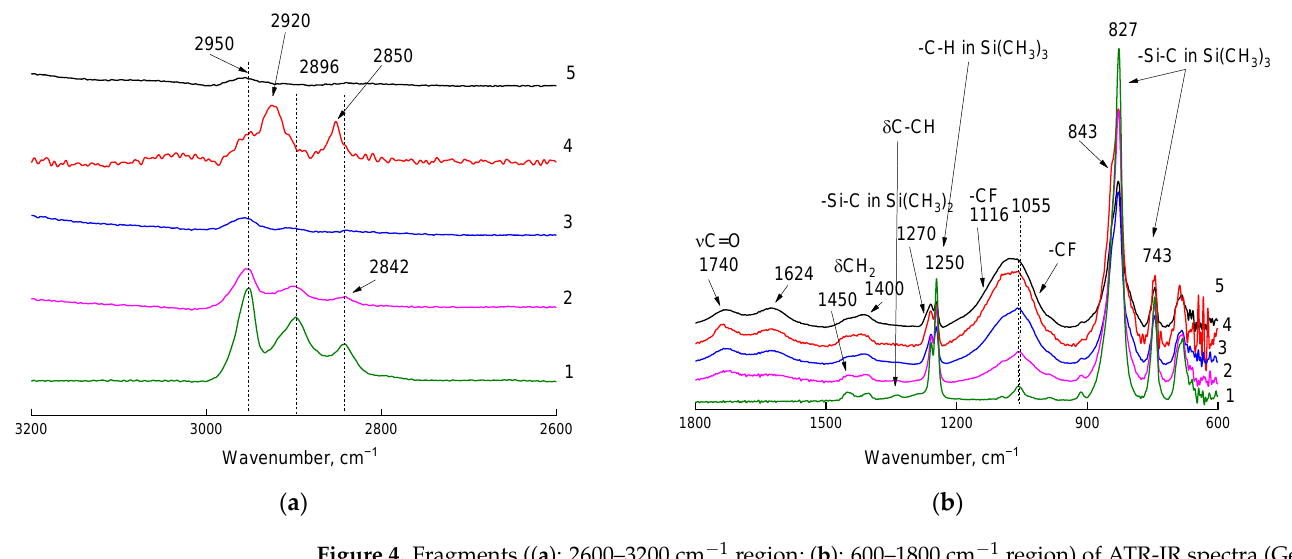
Figure 4. Fragments (( a ): 2600–3200 cm −1 region; ( b ): 600–1800 cm −1 region) of ATR-IR spectra (Ge crystal) of the PVTMS film recorded on the side of fluorination. Curve 1: original film; curves 2–5: films fluorinated for 15, 30, 45, and 60 min, respectively.